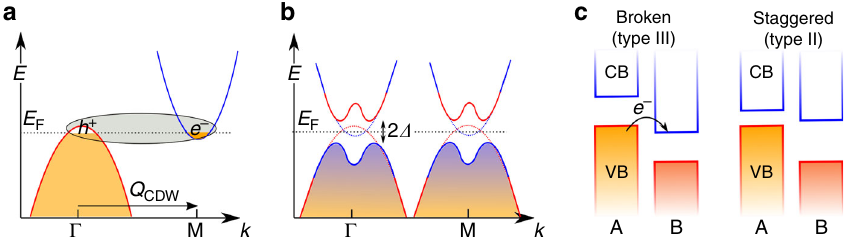
Fig. 1 Excitonic condensation in broken-gap 2D bilayer heterostructures. a Band alignment in a semi-metallic system with distinct electron and hole pockets necessary for exciton condensation. b For such a system with a negative gap ( E g ) or when E g < E b (the exciton binding energy), the semi-metallic state becomes unstable and opens a gap for an arbitrarily weak electron-hole attraction. The semimetal now transitions to an excitonic insulator, with a gap of 2 Δ in the excitation spectrum. c For a broken-gap band alignment, the electron is transferred to the conduction band of the acceptor layer B, with a hole remaining in the valence band on the donor layer A. In a staggered-gap alignment, band overlap can be tuned by external